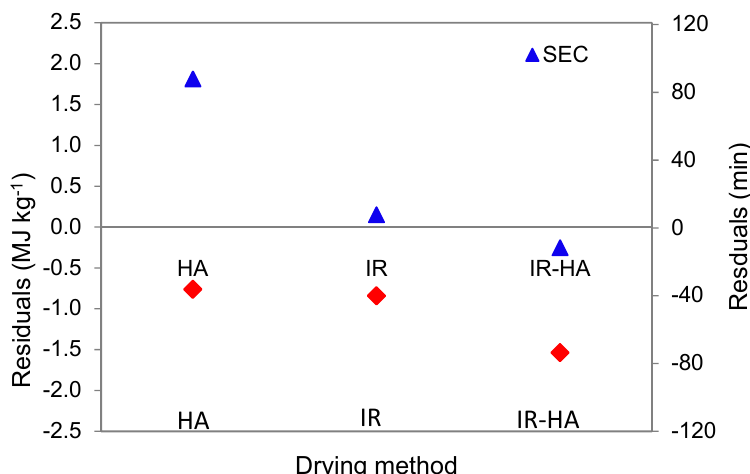
Figure 5. The effect of infrared intensity at different air velocities on the specific energy consumption (SEC) using a combined dryer at 40 °C ( A ), 50 °C ( B ) and 60 °C ( C ). The different capital letters at the same infrared intensity showed significant differences, while different lowercase letters of the same series showed significant differences (at P ≤ 0.05).